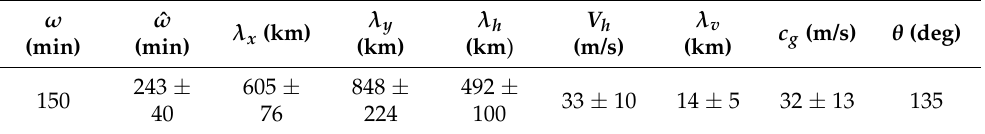
Table 1. Intrinsic parameters of the 150 min wave. From left to right: the observed period, the intrinsic period, the zonal wavelength, the meridional wavelength, the horizontal wavelength, the intrinsic horizontal phase speed, the vertical wavelength, the group velocity, and the direction of